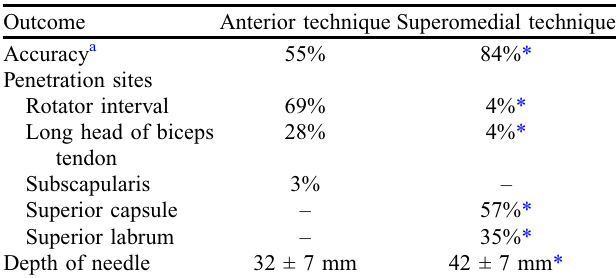
Table 1. Summary of accuracy, penetration, and depth of needle.